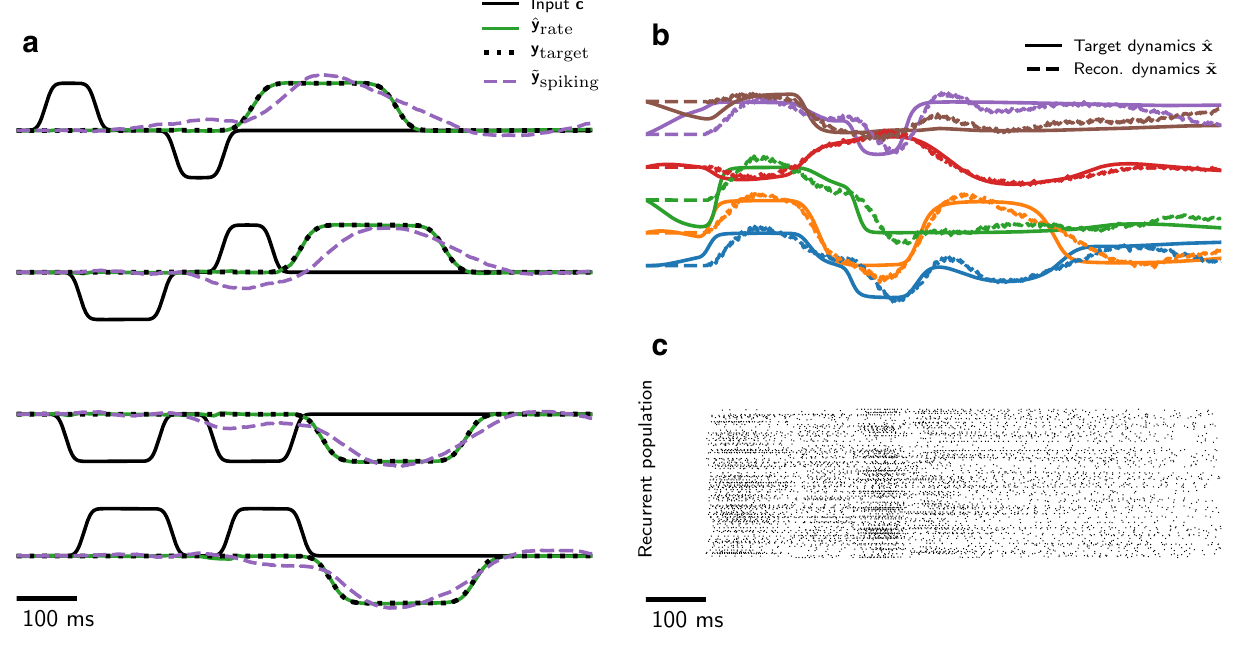
Figure 2. Our approach implements a supervised temporal non-linear sequence classification task to high accuracy. ( a ) The non-spiking RNN (green; ˆ N = 64 neurons) is trained to perform a temporal XOR of the input (black), closely matching the target function (dotted). A spiking ADS network (dashed; N = 320 neurons) is trained to perform the same task. ( b ) The first six internal dynamical variables ˆ x of the RNN are shown (solid), along with their reconstructed equivalents ˜ x from the spiking ADS network (dashed). ( c ) The spiking activity of the ADS network. Panels ( b ) and ( c ) correspond to the first example in ( a